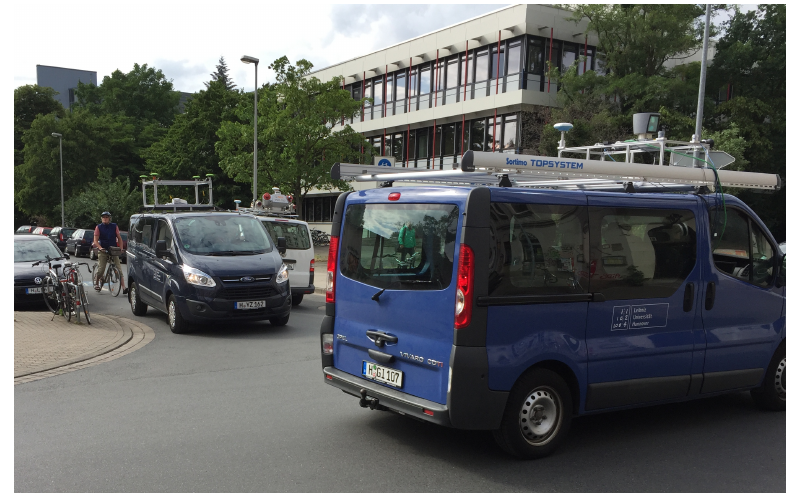
Figure 6. Photograph of a typical situation during the mapathon: in the first Meet & Greet scenario, all three cars meet at a junction (from left to right: IfE, IKG, GIH van).